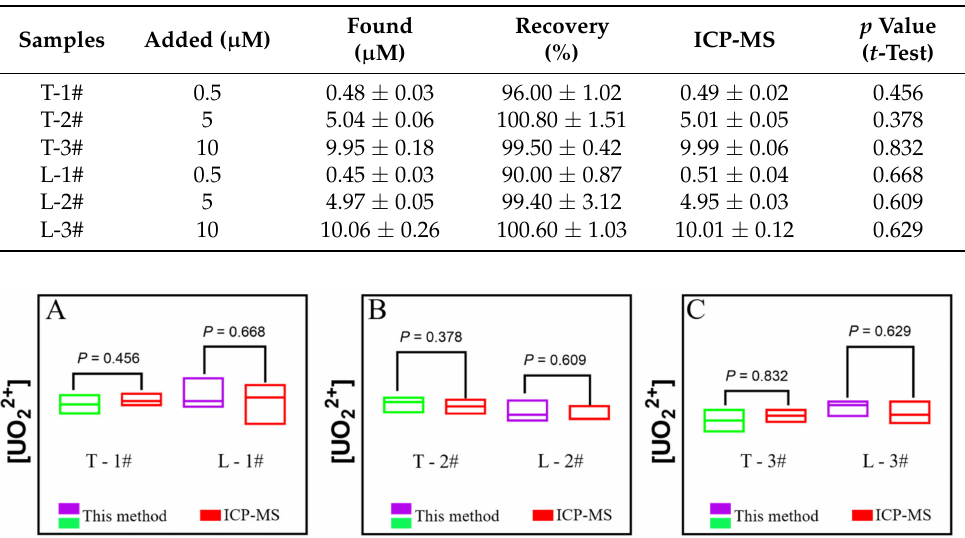
Figure 5. Floating bars plot of UO 22+ contents of different samples by colorimetric assay. ( A ) T-1# and L-1#. ( B ) T-2# and L-2#. ( C ) T-3# and L-3#. (Student’s t -test by GraphPad Prism 9, p > 0.05, no significant